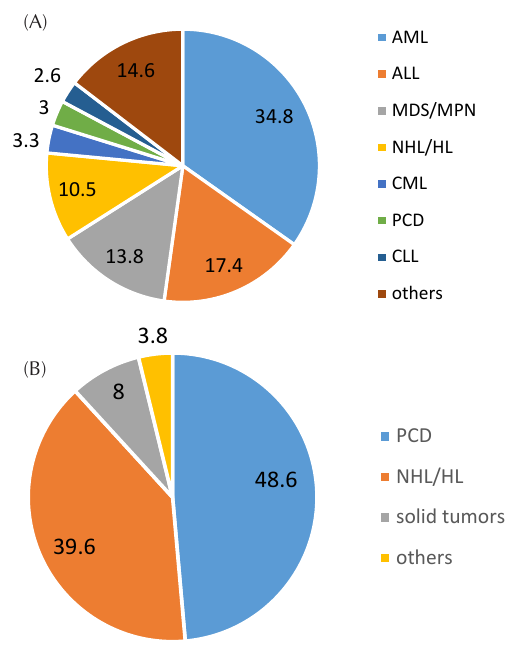
Figure 2. Indications of Allogeneic (A) and Autologous (B) Stem Cell Transplantations (adapted from Niederwieser et al 43 ). Abbreviations: AML: acute myeloid leukemia, ALL: acute lymphoblastic leukemia, MDS/ MPN: myelodysplastic syndrome/myeloproliferative disease, NHL/HL: non-Hodgkin lymphoma/Hodgkin lymphoma; CML: chronic myeloid leukemia, PCD: plasma cell disorders, CLL: chronic lymphatic leukemia.